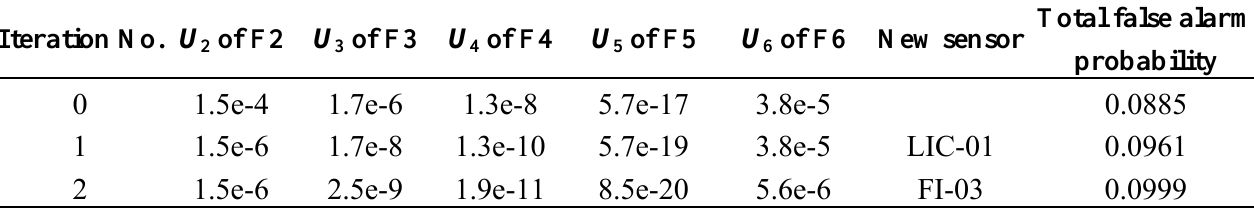
Table 4. Iterative procedure of the